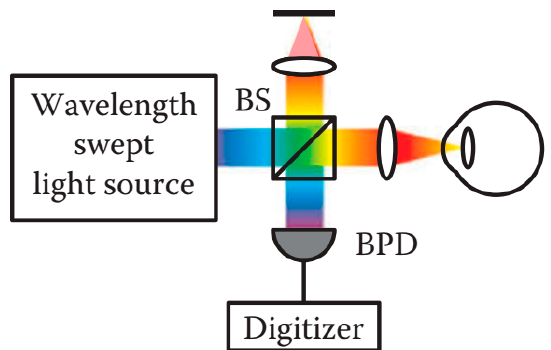
Figure 17. Schematic diagram of a SS-OCT system [85]. BS: Beam splitter; BPD: Balanced photodetector.